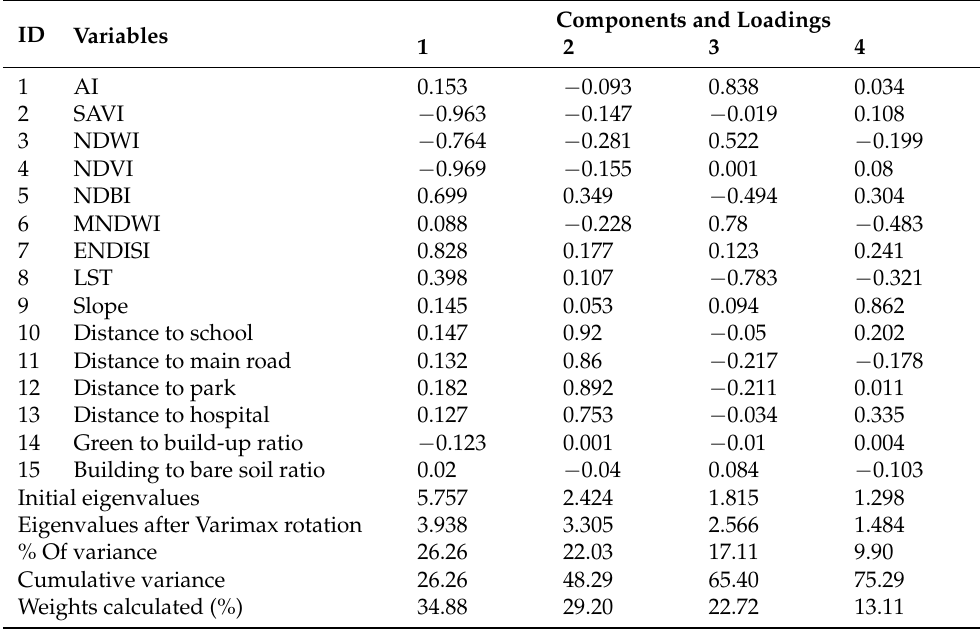
Table 5. Rotated component